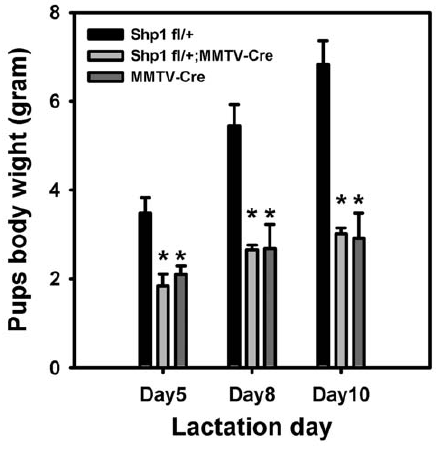
Figure 1. Shp1 fl/ + ;MMTV-Cre and MMTV-Cre display a lactation defect. Shp1 fl/ + (control), Shp1 fl/ + ;MMTV-Cre, and MMTV-Cre female mice were mated with wild type FVB male mouse. On the first day following parturition, the litter size was normalized to 6 pups/litter. Pups were weighted at lactation days 5, 8, and 10. The average weight of each litter is shown and bars indicate the standard deviation (SD). ** indicates P , 0.001. The data shown is representative of at least two independent experiments.